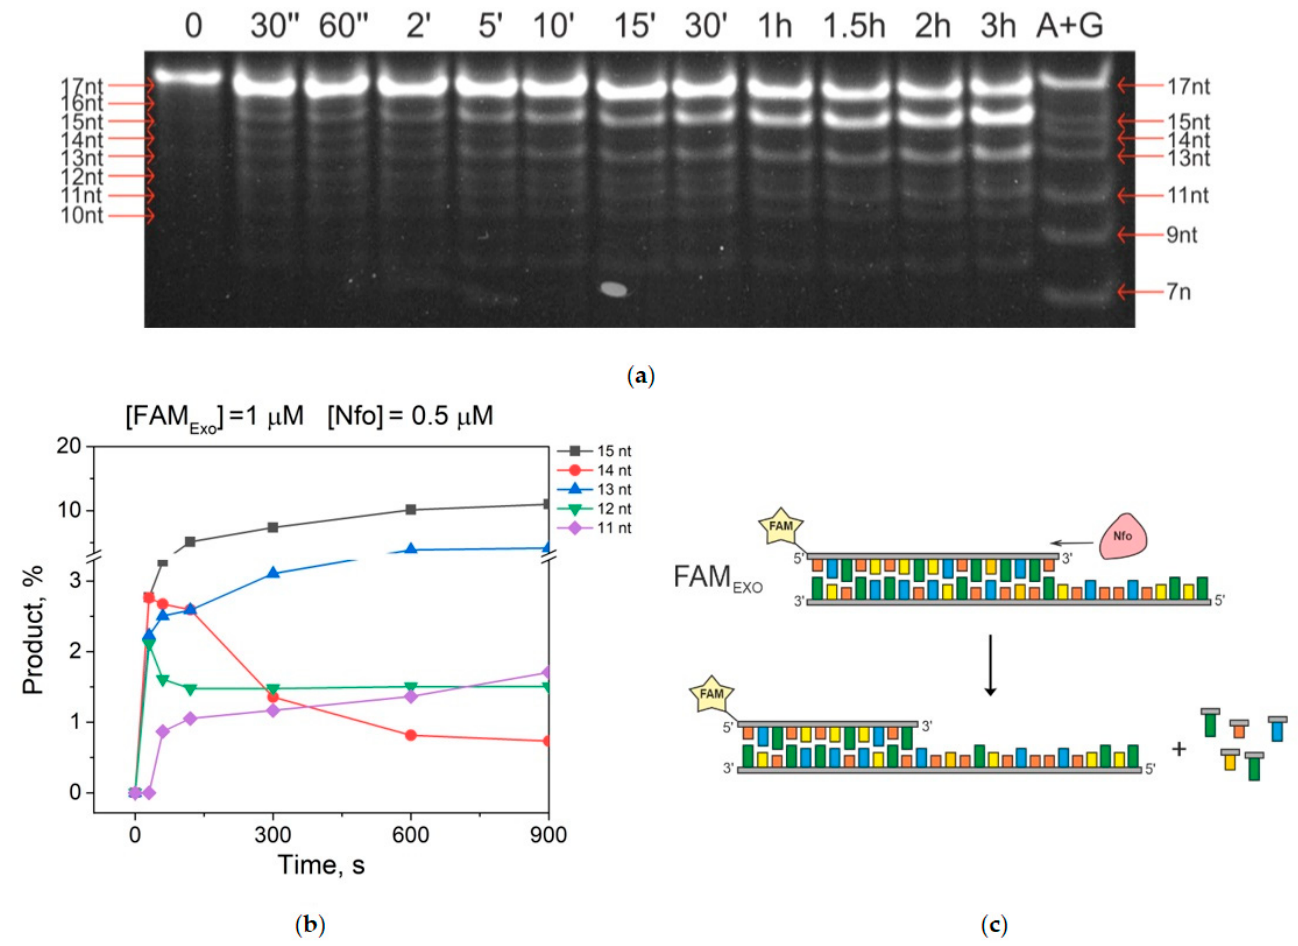
Figure 3. Visualization of the original DNA substrate (lane 1) and its degradation products after interaction with Nfo (lanes 2–12). Cleavage of substrate DNA at purine bases using the Maxam– Gilbert method (lane 13) ( a ). Kinetics of the accumulation and consumption of intermediate products of sequential cleavage of 3 ‐ terminal nucleotides ( b ). Schematic representation of the interaction of Nfo with a DNA substrate accompanied by sequential cleavage of 2 ‐ deoxynucleoside monophosphates from the 3 end of the short strand. [FAM Exo ] = 1.0 μ M and [Nfo] = 0.5 μ M ( c ).